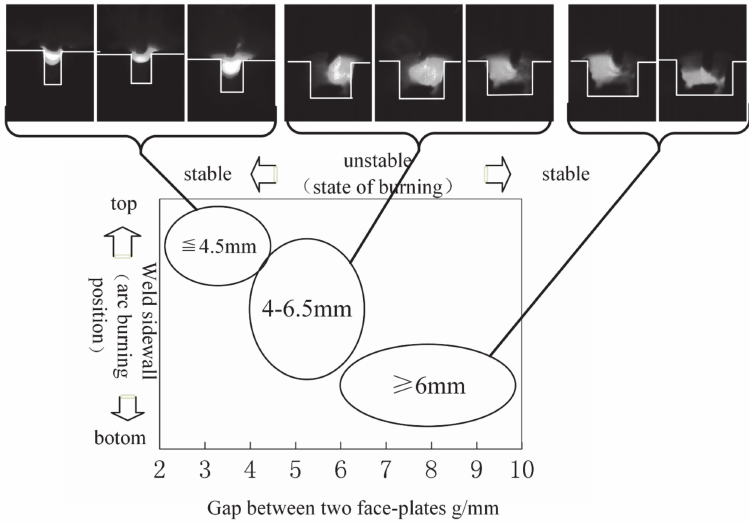
Figure 7. Relationship between weld groove gap and arc burning